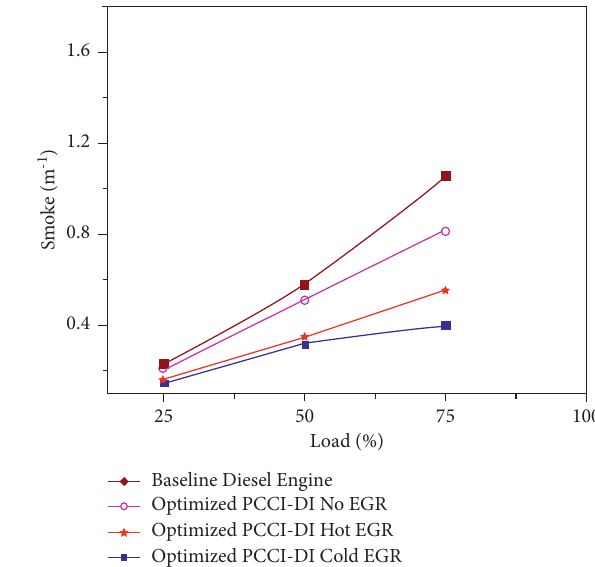
Figure 4: Effects of EGR configurations on HC versus load.